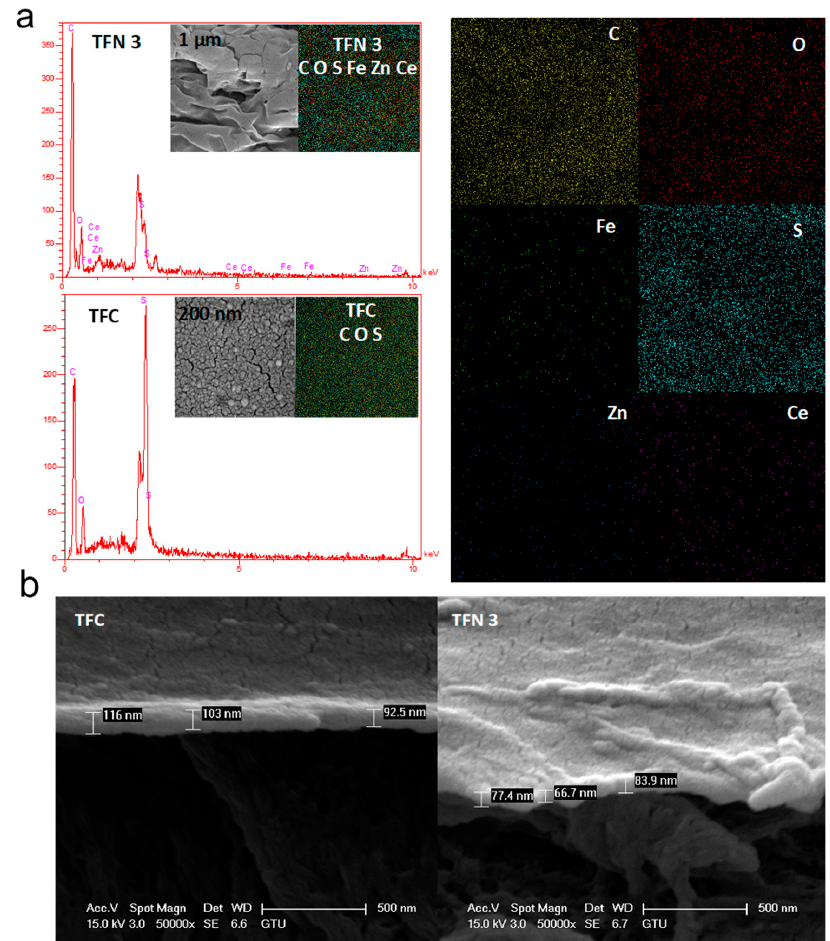
Figure 2. EDS mapping ( a ) and cross-section images ( b ) of TFC and TFN 3 membranes.